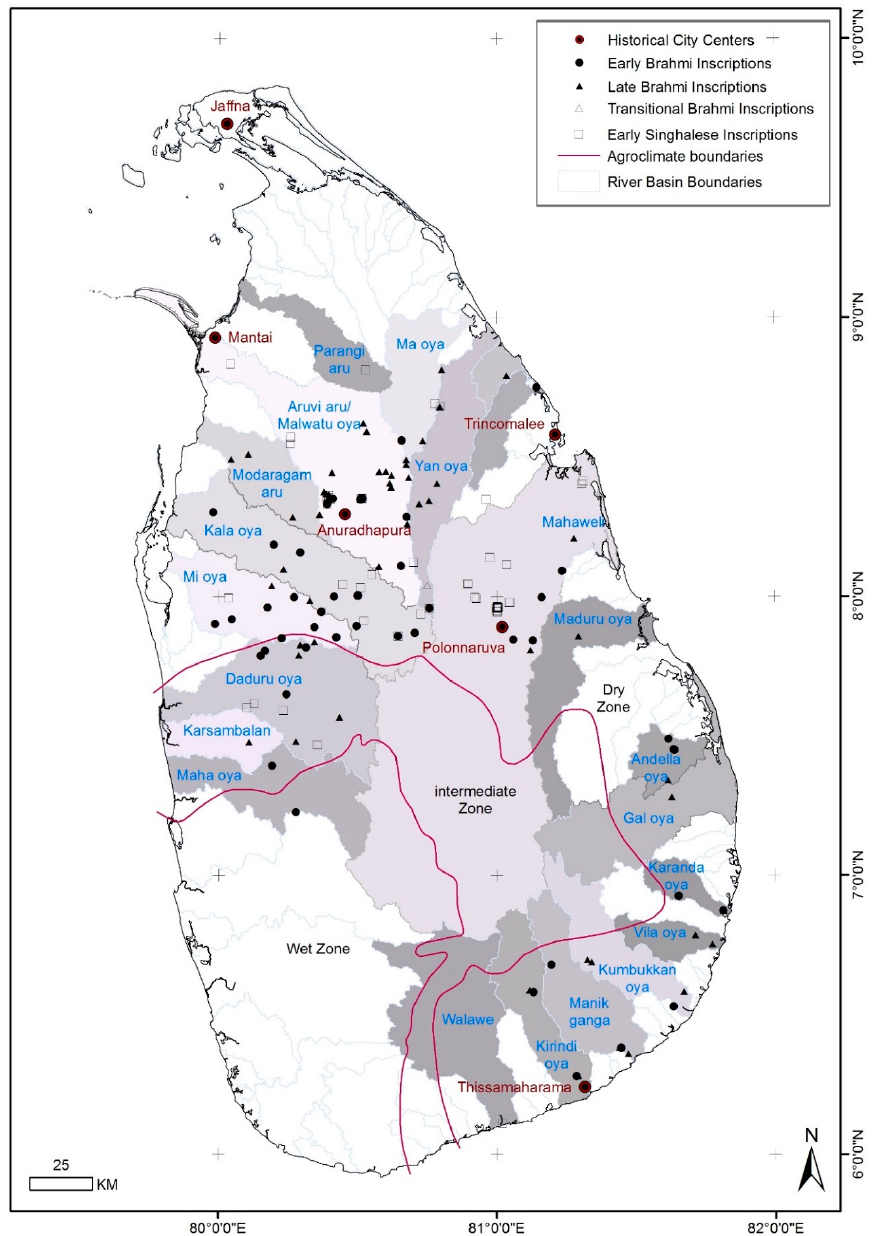
Figure 4. Spatial distribution of lithic inscriptions in Sri Lanka containing information on ancient water governance structures correlated with the river basins. (Relative locations of the inscriptions were assigned by correlating the place names mentioned in the official English translations of the inscriptions with 1:50,000 topographic data compiled by the Sri Lanka Survey Department. Agro climate boundaries are based on the National Atlas of Sri Lanka [22]).